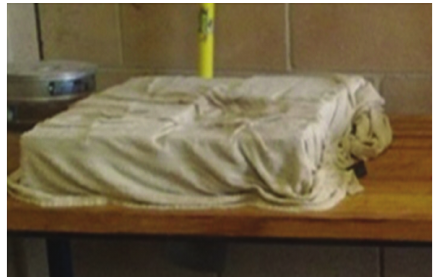
Figure 1: Membrane curing